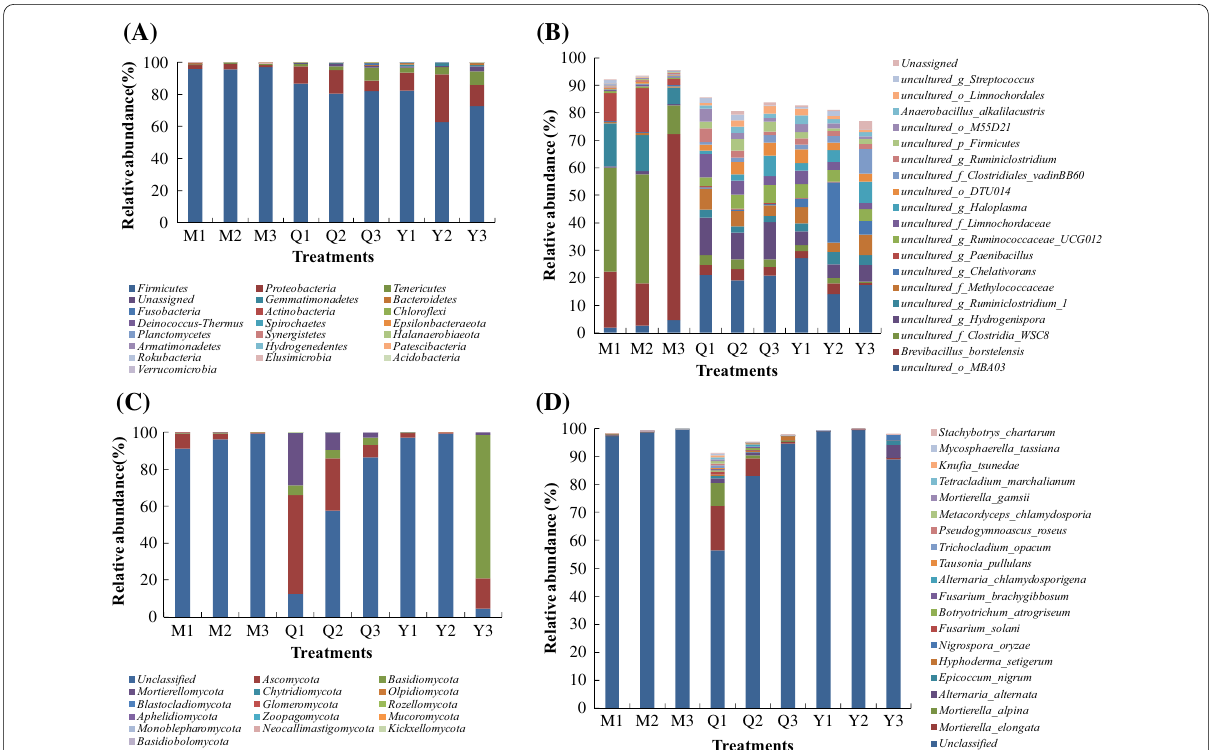
Fig. 4 The bacterial ( A / B ) and fungal ( C / D ) phyla ( A / C ) and top 100 species ( B / D ) in different